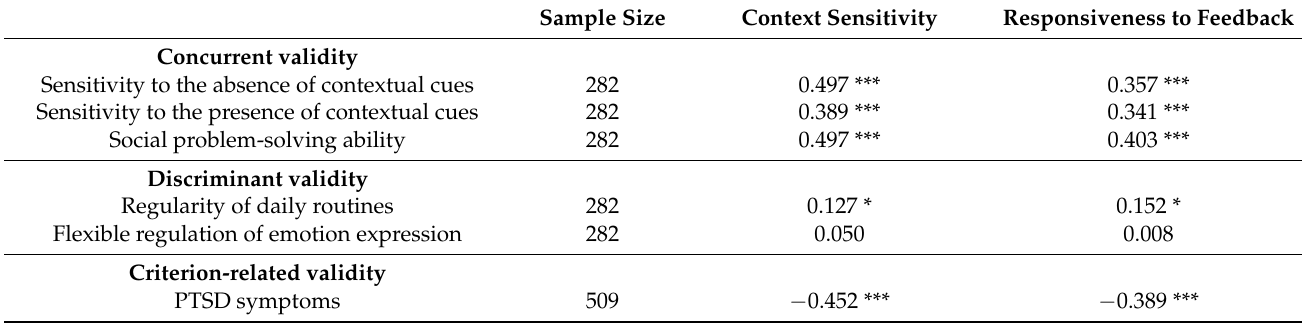
Table 2. Pearson correlations between regulatory flexibility in daily routines and self-reported instruments in Study